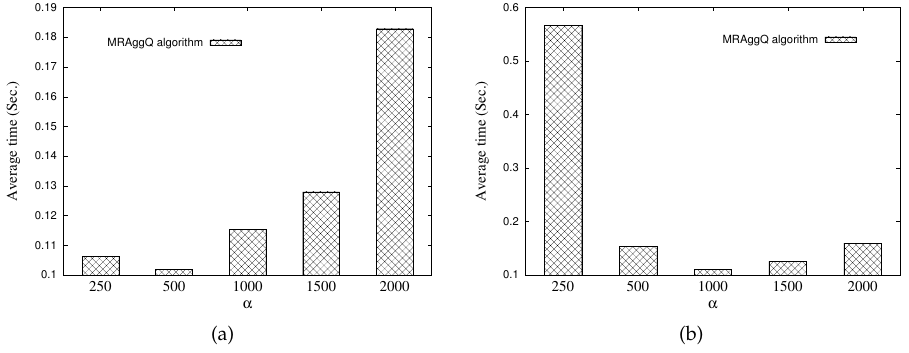
Figure 8. Effect of the parameter α . ( a ) Uniform dataset; ( b ) Manchester